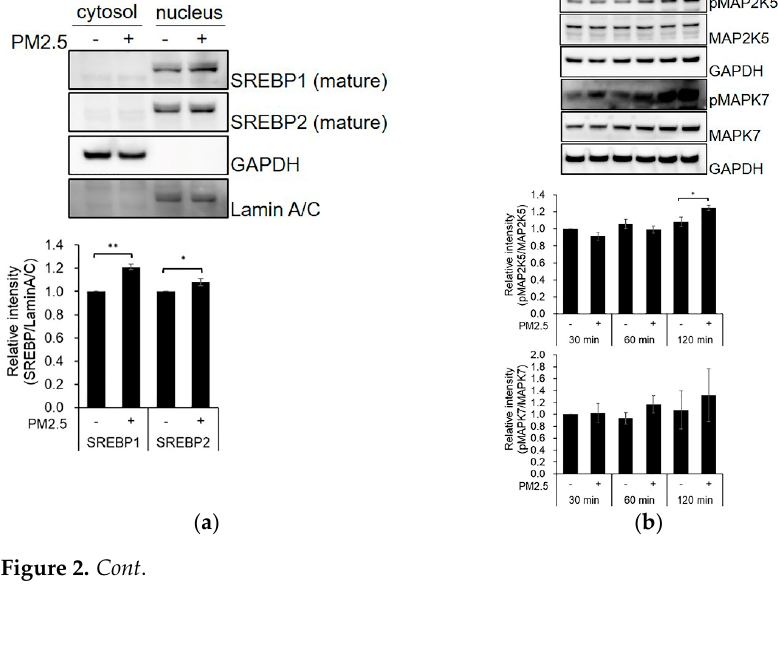
Figure 2. PM 2.5 affects SREBP-, MAPK-, TGF β -SMAD3-, and FoxO3a-related signaling. ( a ) SZ95 sebocytes were treated with PM 2.5 (100 μ g/mL) for 48 h. The cells were lysed with hypotonic buffer, and the cytosolic fraction and nuclei were separated. SZ95 sebocytes were treated with PM 2.5 or TGF β for the indicated times ( b , c ) or 48 h ( d ). The expression levels were analyzed by SDS-PAGE and immunoblotting for the indicated antibodies. The relative intensity of proteins was quantified using the Image J program. Data were analyzed by Student’s t -test (* p < 0.05, ** p < 0.01 vs. untreated control; n = 3).